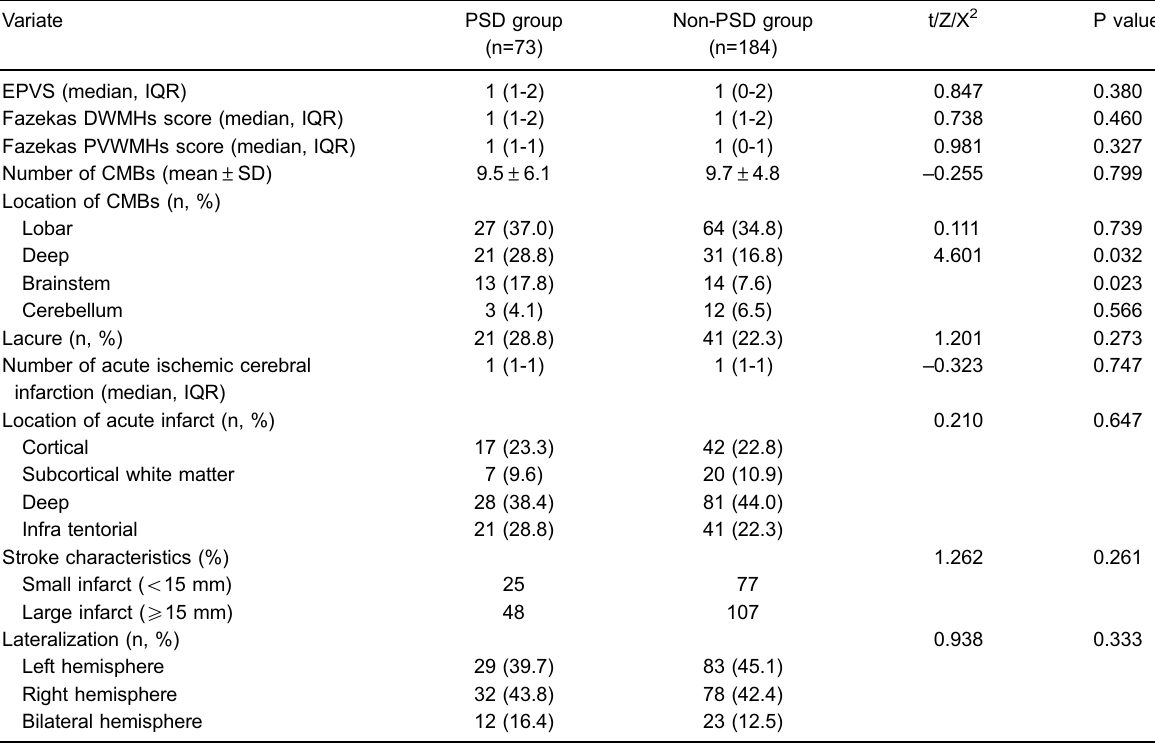
Table 3. Imagining characteristics in patients with and without post-stroke depression (PSD) at 1 month.